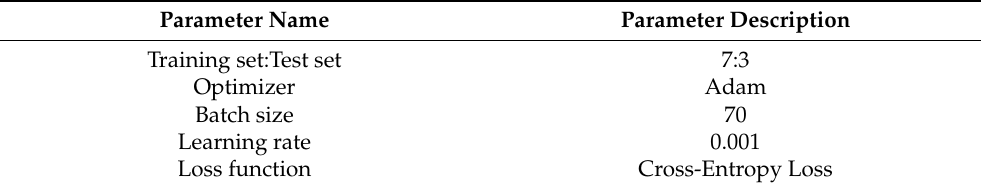
Table 2. 1D-WL-G-MN network training